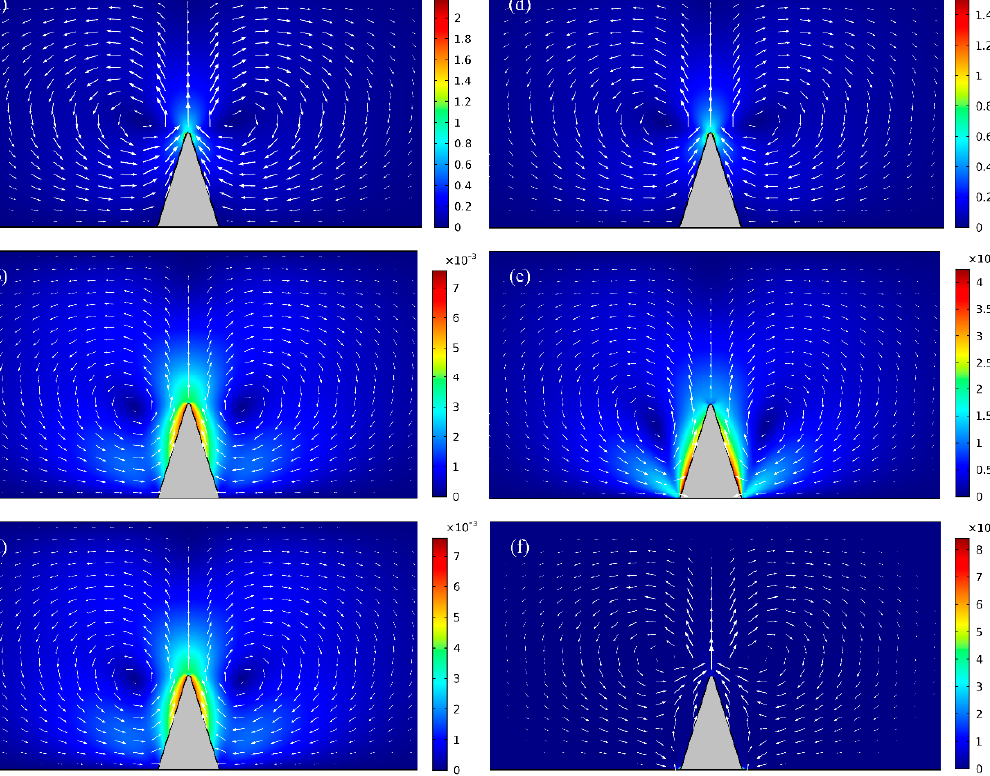
Figure 2. A surface and arrow plot of nonlinear electroosmotic flow field around an individual triangular block of different bulk conductivities at distinct field frequencies (unit: m/s). ( a )–( c ) under low-frequency limit ( f = 10 Hz), ( a ) for σ b = 0 S/m (insulating dielectric block of no internal charge carriers); ( b ) for σ b = σ f = 0.001 S/m (semiconductor block); ( c ) for σ b = 10 4 σ f = 10 S/m (ideally polarizable block). ( d )–( f ) at a much higher field frequency f = 100 kHz approaching the reciprocal charge relaxation time of fluid bulk, ( d ) for σ b = 0 S/m; ( e ) for σ b = σ f = 0.001 S/m; ( f ) for σ b = 10 4 σ f = 10 S/m.